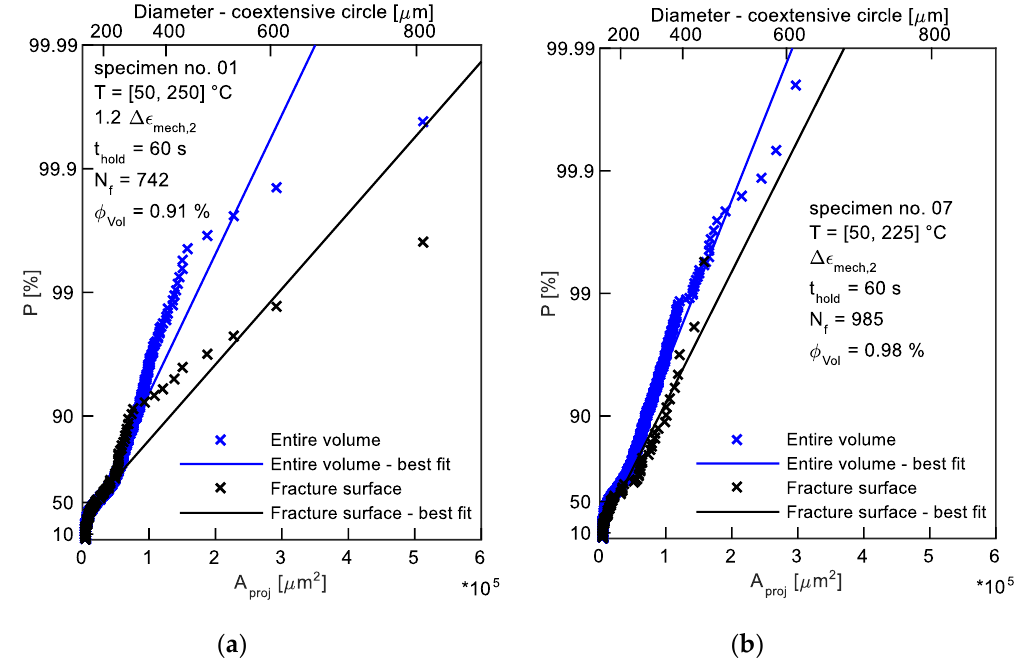
Figure 11. A proj in probability plot of exponential distribution—pores within the entire volume (blue) and exclusively on the fracture surface (black). ( a ) Specimen No. 01; ( b ) Specimen No. 07.